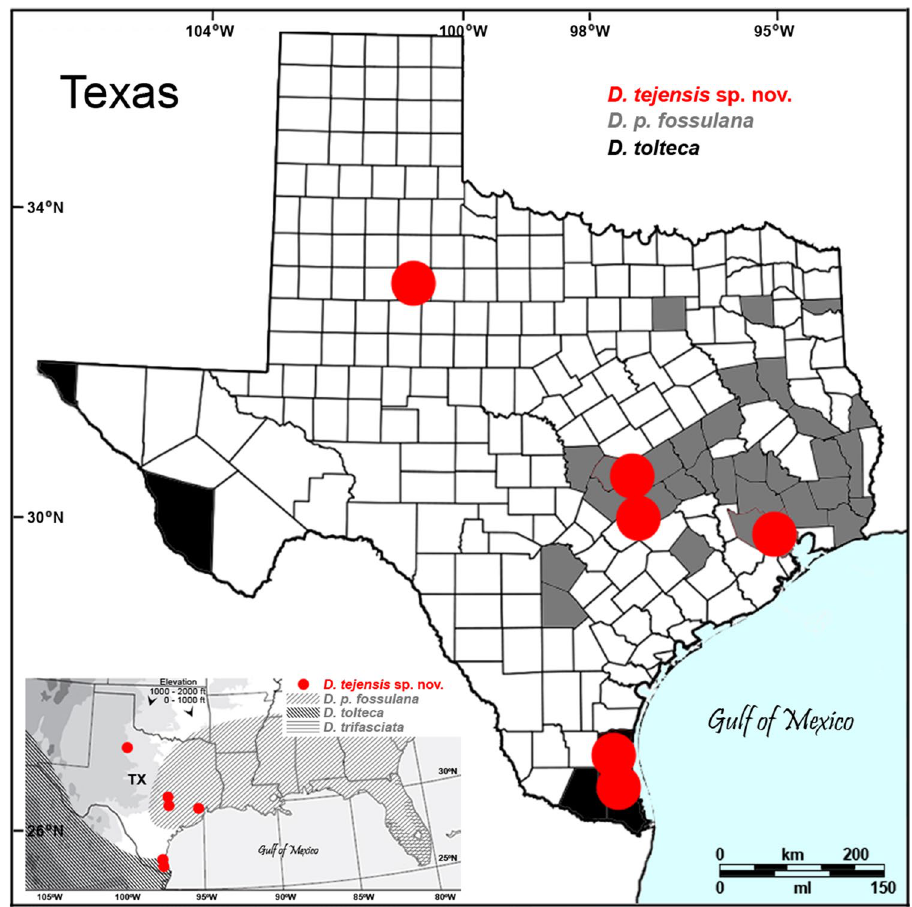
Figure 3. Geographic distribution of D. tejensis sp. nov. and similar species of Dielis . Contemporary and historical (published 30 , TAMU and FSCA) records are plotted on contour maps obtained from Wikimedia Commons and